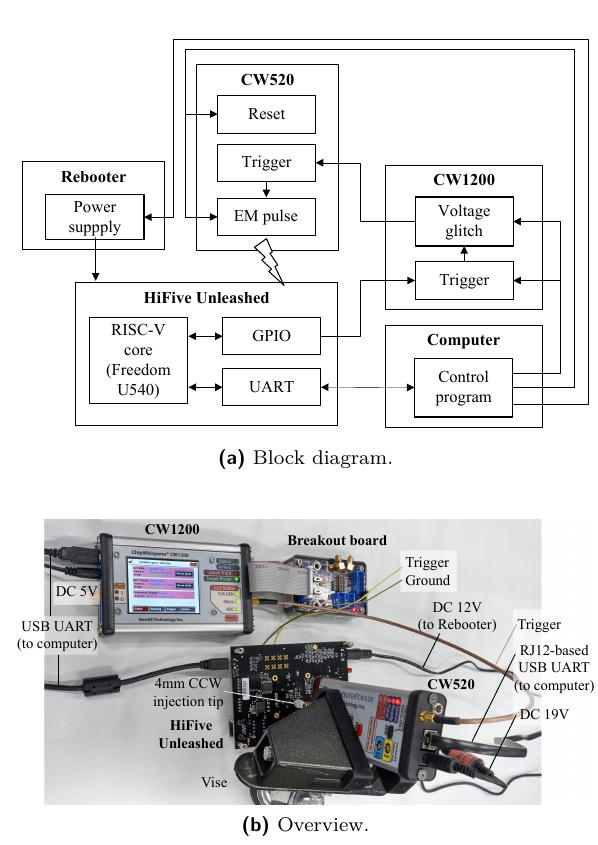
Figure 11: Experimental setup. Computer is connected to HiFive Unleashed, CW520, and CW1200 with USB, and HiFive Unleashed and CW1200 are connected with wires. CW520 and CW1200 are connected with coaxial cable. Rebooter provides power for HiFive Unleashed. CW520 is fixed in position by vise. There is no hardware